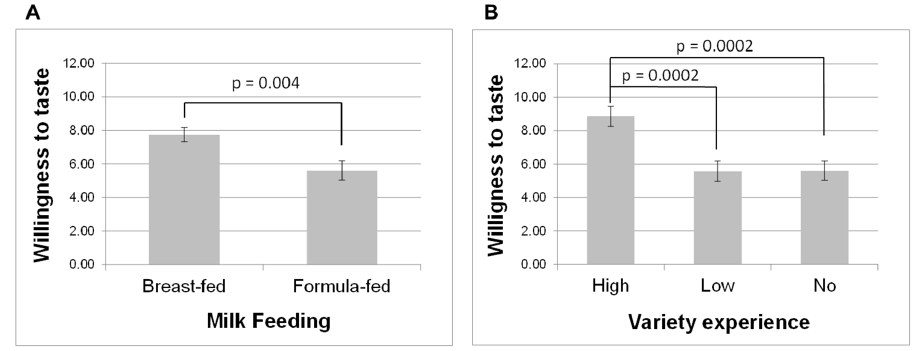
Fig 7. Early food-related variety experience is associated with higher willingness to taste vegetables. Mean ( ± SE) at follow-up 3, i.e. when children were on average 6 years old. A: for breast-fed and formula-fed infants; B: for the three experimental groups (no, low and high